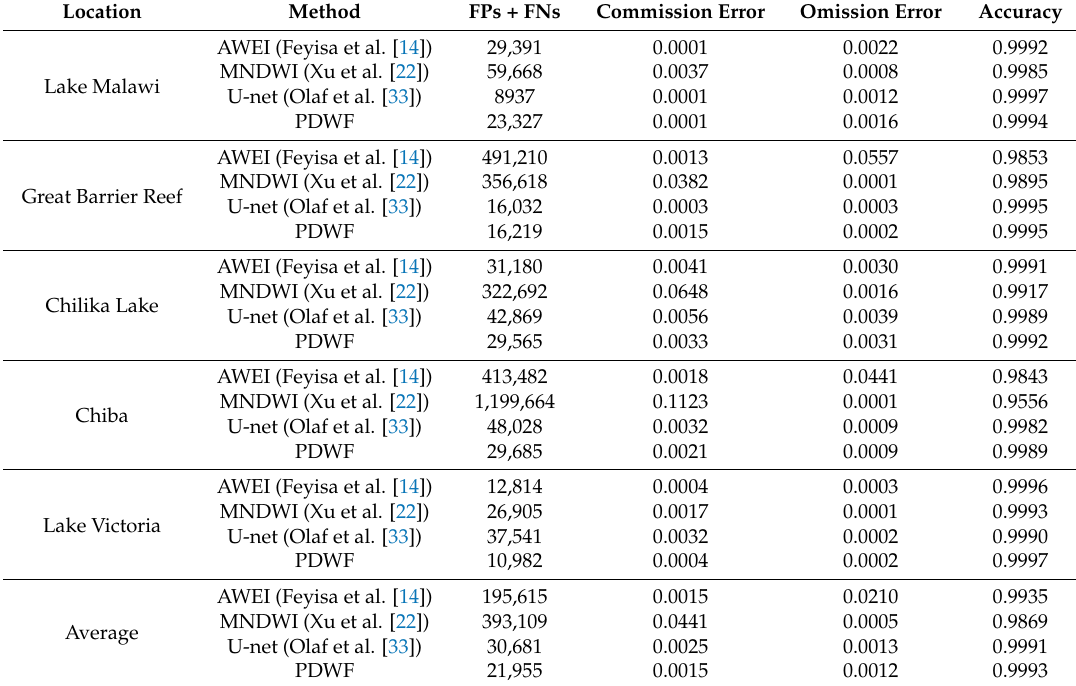
Table 3. Quantitative evaluation of the performance of Automatic Water Extraction Index